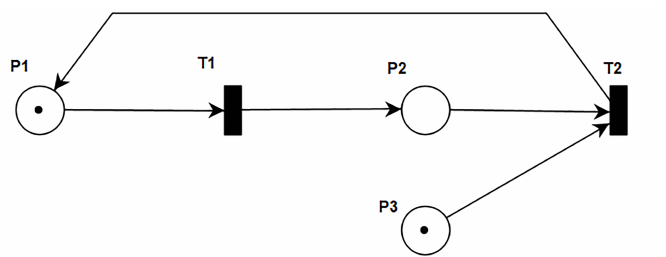
Figure 1. A simple Petri